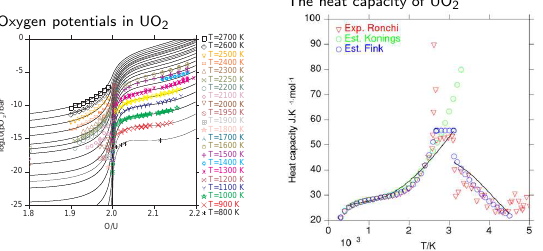
Bo Sundman and Christine Gu´eneau (INSTN and DEN/DANS/DPC/SCCME, CEA Saclay)The use of Computational Thermodynamics to predict properties of multicomponent materialsDecember 5, 2012 12 /